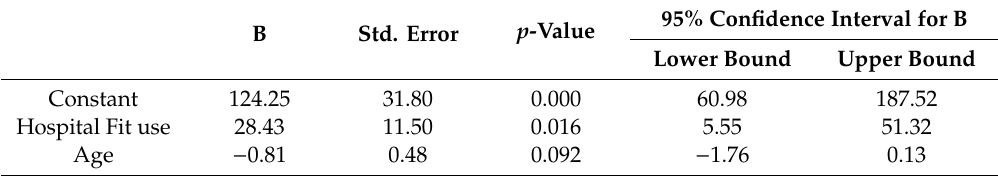
Table 3. Multiple linear regression analysis—the association between the time spent physically active on POD1 and Hospital Fit use, corrected for age. B Std. Error